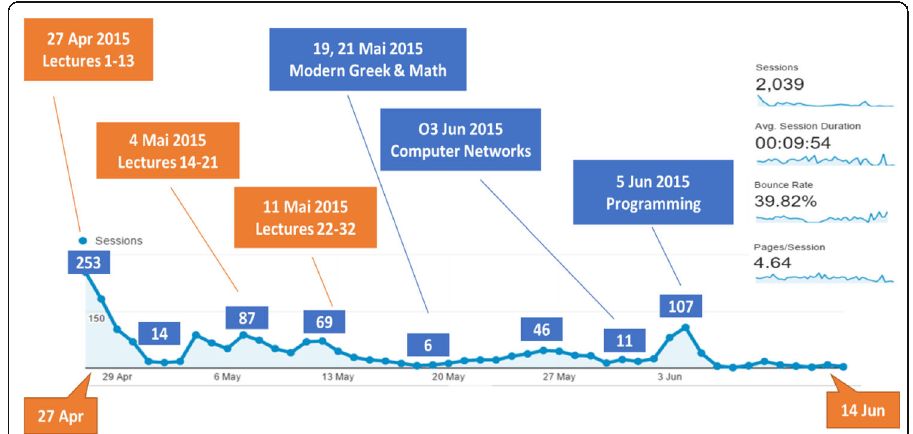
Fig. 9 Connections per day, Total number, Duration, Pages per